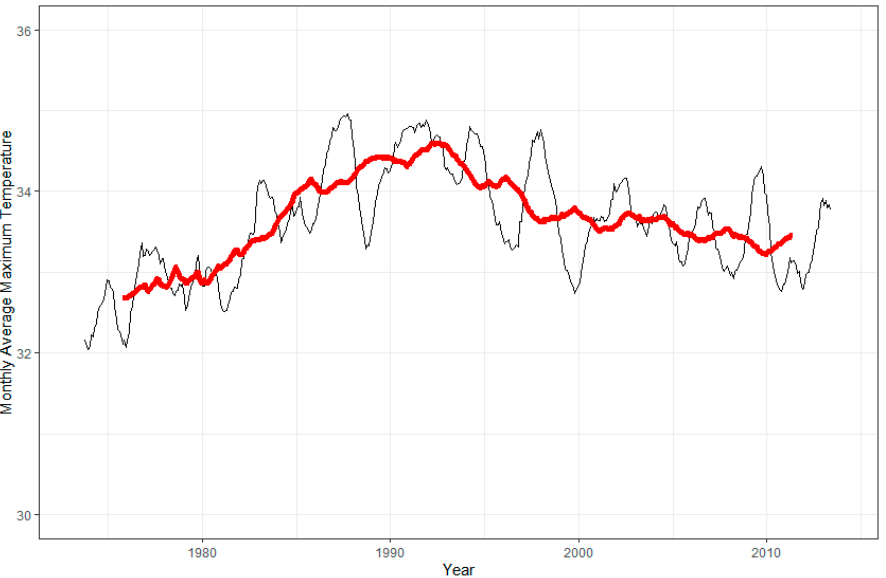
Figure 1. One-year (black line) and five-year (red line) rolling averages of monthly-averaged daily maximum temperatures at ISA, all months in the period May 1973–November 2013. Monthly minimum temperature was inversely associated with time ( − 0.004 °C/month;